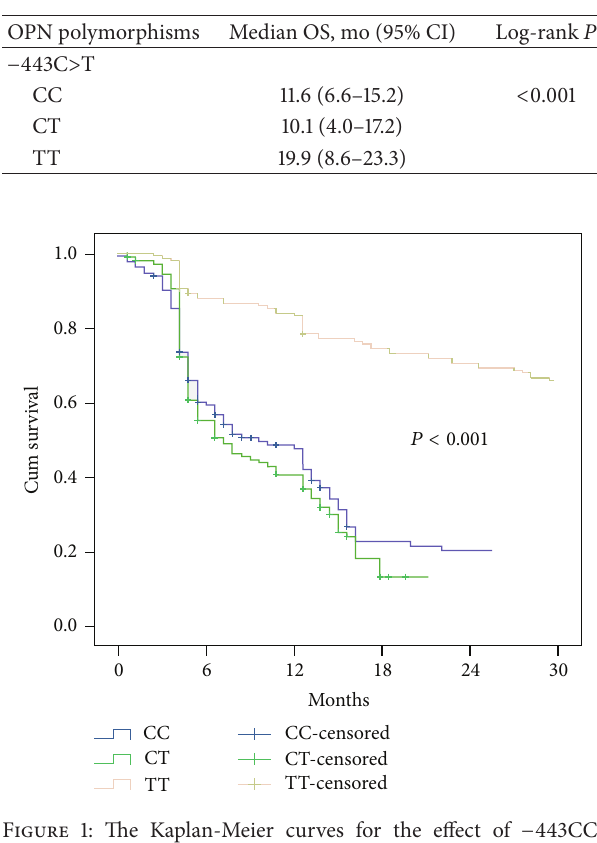
Table 3: The associations between − 443T > C genotype and OS by log-rank test.